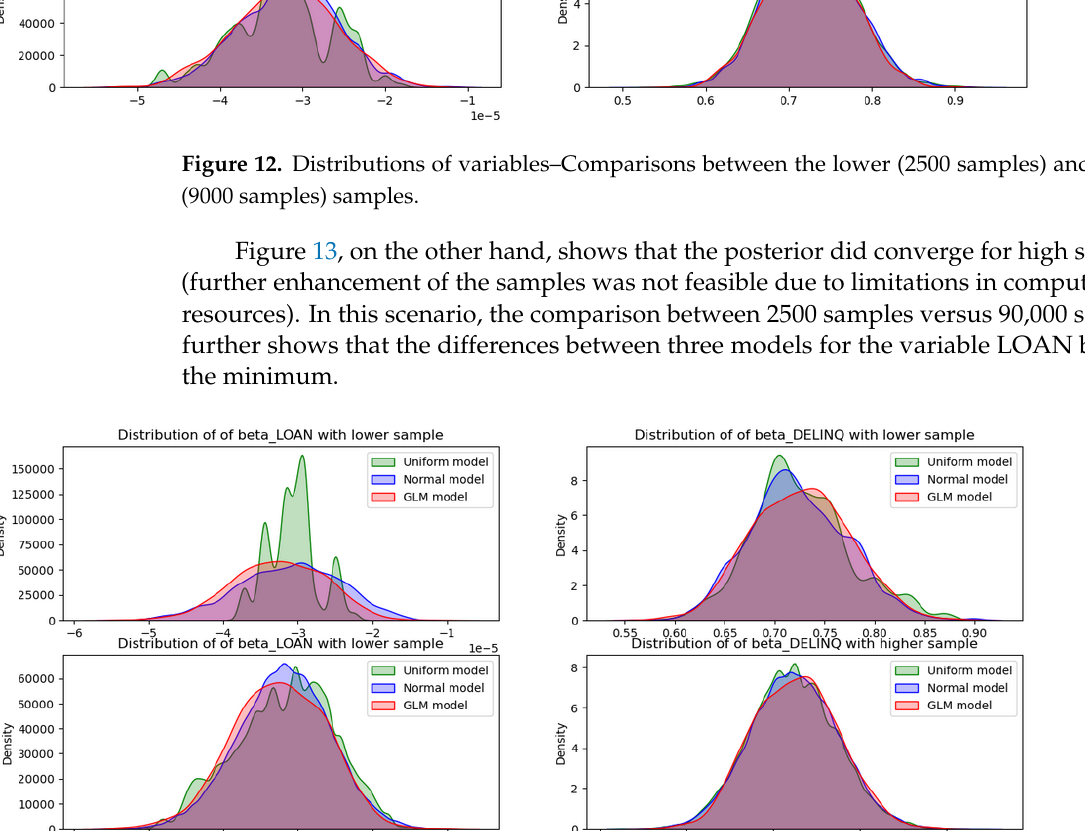
Figure 14. Distribution of the y-score for Bayesian using uniform, normal, and built-in GLM pri- ors.